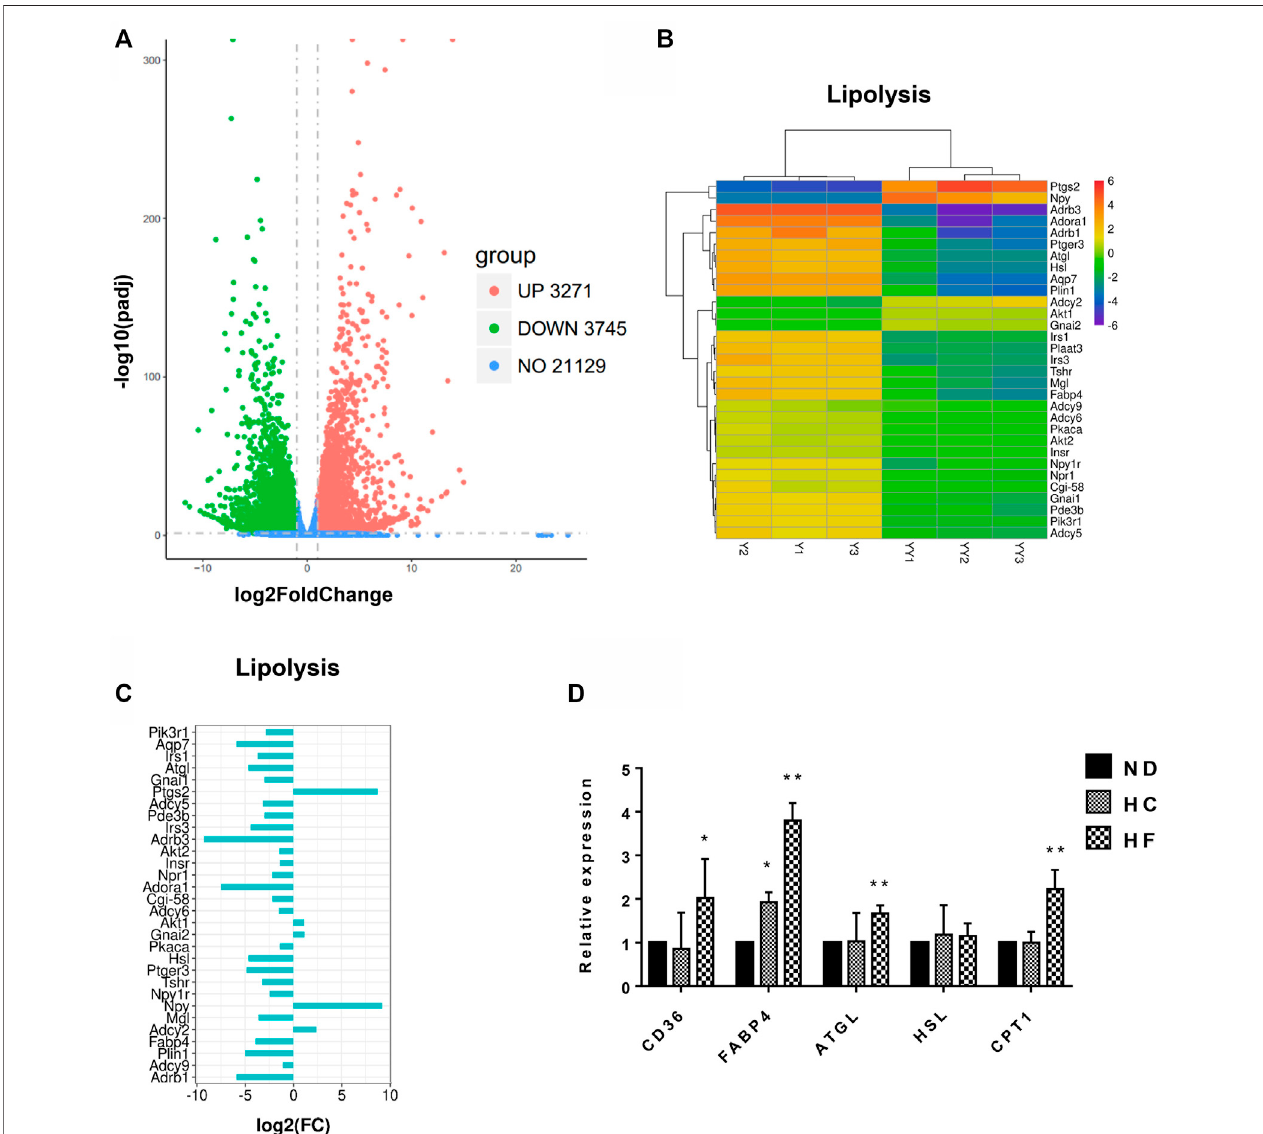
FIGURE1| Transcriptomedataanalysisoffattissuesbeforeand1 weekaftergrafting,andthegeneschangesintheinguinalfatofmicefedwithdifferentdiets. (A) Volcano plotsofallexpressed genesinsamplesbefore(Y1,Y2, Y3)and 1 weekafterfatgrafting(YY1,YY2,YY3). (B) Heatmap ofdifferentiallyexpressed lipolytic genes. (C) HistogramofLog2Foldchange(FC)ofthedown-regulatedlipolyticgenesintissuesbeforeand1 weekaftergrafting. (D) Lipolysisgeneexpressionwasexaminedby qPCR. ** p < 0.01 and * p < 0.05. n = 6 mice.